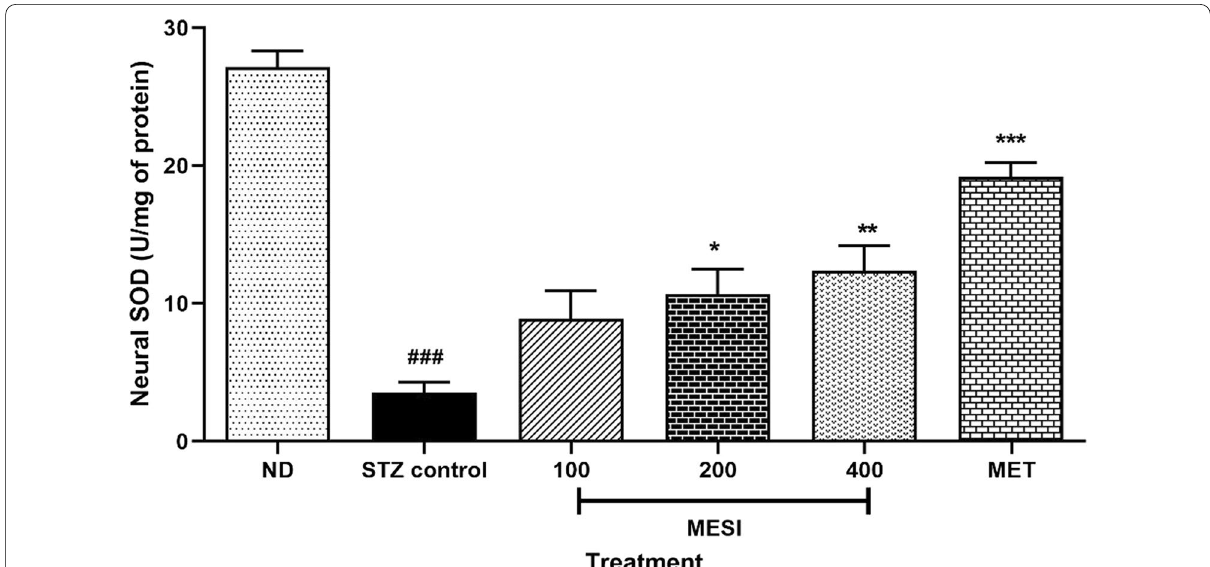
Fig. 7 Effect of MESIon diabetes-induced alterations in the superoxide dismutase (SOD) level. Data are expressed as mean analyzed by one-way ANOVA followed by a post hoc Tukey’s multiple range test. *P < 0.05, **P < 0.01 for MESI, and *** P < 0.001 for metformin-treated groups compared to the diabetic (STZ) control group. ### P < 0.001 for the diabetic (STZ) control group compared to the normal non-diabetic group.